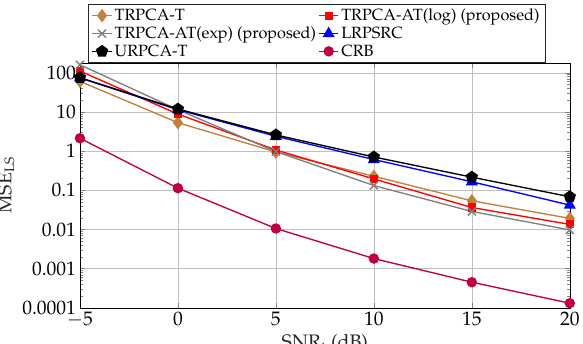
Figure 6. Average combined recovery error of low-rank and sparse matrices as given in (25) and Cramér-Rao bounds as given in (A4) for compression ratio K / MN = 100% for ADMM-based trained RPCA with thresholding (TRPCA-T), proposed ADMM-based trained RPCA with adaptive thresholding based on logarithm heuristic (TRPCA-AT(log)), proposed ADMM-based trained RPCA with adaptive thresholding based on exponential heuristic (TRPCA-AT(exp)), low-rank plus sparse recovery with convex relaxation (LRPSRC), and ADMM-based untrained RPCA with thresholding (URPCA-T).